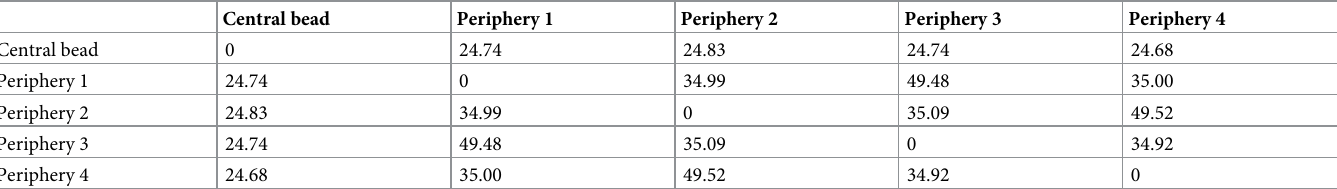
Table 3. Euclidean distances, in mm, between the centroids of all five beads of the geometric accuracy plate of the CT quality assurance